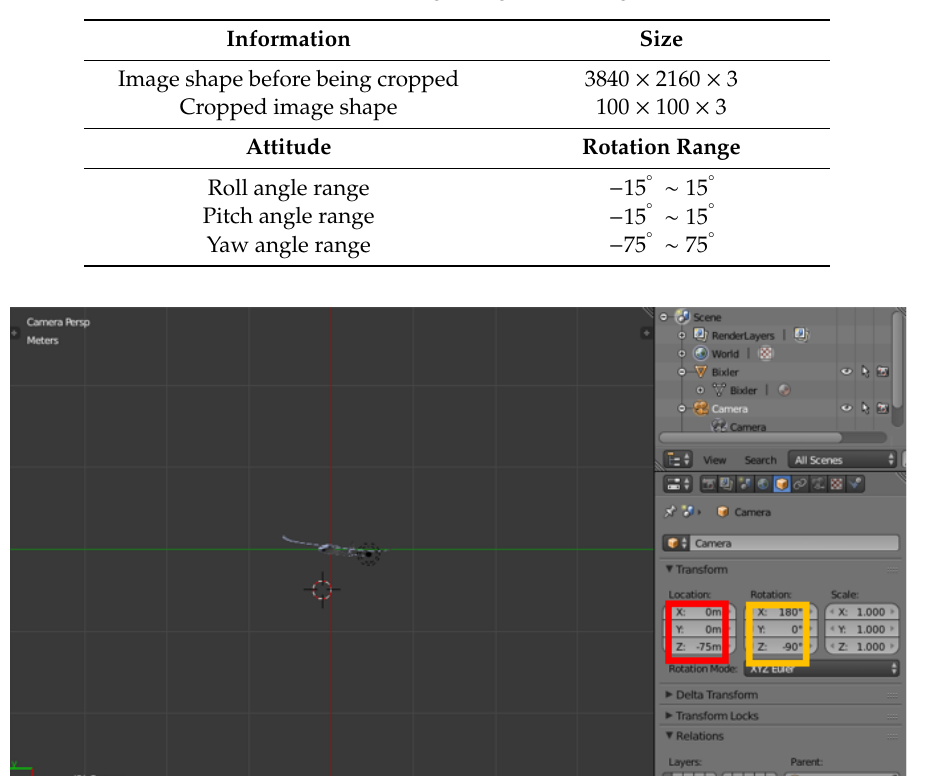
Figure 10. Using Blender to collect images to train the model.